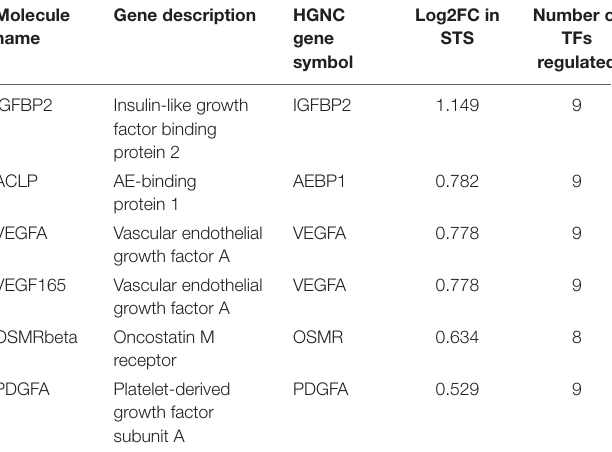
TABLE 3 | Table of the master regulators identified, their description, log2FC in STS, and number of transcription factors